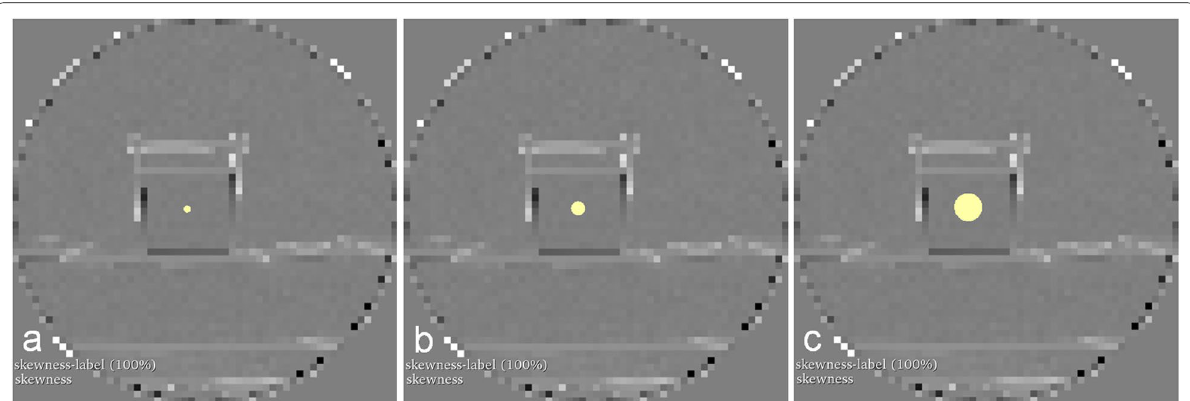
Fig. 2 Extraction of feature quantity from parametric maps. Slices of the parametric maps of the first‑order feature skewness are shown. We copied volumes of interest (VOIs) with 4 ( a ), 8 ( b ), and 16 ( c ) mm diameter from the conventional feature extraction onto the maps. Feature quantities, visualised by the map, were extracted with PyRadiomics using the mean value of the